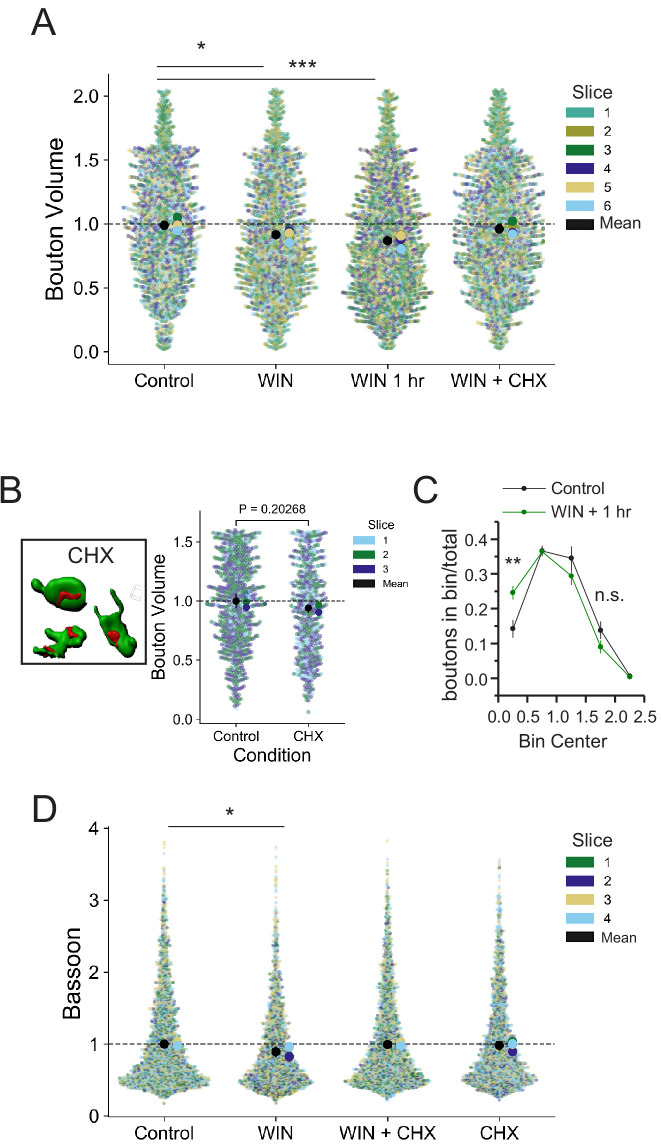
Individual bouton and Bassoon sizes are altered by CB1-iLTD induction in a protein synthesis-dependent manner.(A) Quantification of bouton volume normalized to control by slice. Activation of CB1 receptors with 5 µM WIN for 25 min led to decreased bouton volume that remained 1 hr after WIN treatment and was diminished by treatment with cycloheximide (CHX, 80 µM, applied throughout the experiment). Superplot shows individual bouton volume values color-coded by slice in swarmplot with solid larger dots overlaid representing mean bouton volume per slice. Overall mean of slices is indicated with the black circle, 95% CI is indicated with the vertical black line. Control: 1.0 ± 0.02 vs. WIN: 0.92 ± 0.02 vs. WIN + 1 hr: 0.87 ± 0.02 vs. WIN + CHX: 0.98 ± 0.02 (Mean ± S.E.M.); F[3,20]=8.40, p=0.00082, one-way ANOVA with post-hoc Tukey test for multiple comparisons. WIN vs. Control: CI [−0.15,–0.0015], p=0.044, WIN 1 hr vs. Control: CI [−0.19,–0.048], p=0.00077, WIN + CHX vs. WIN 1 hr: CI[0.02,0.16], p=0.0095. n = slices (three images/slice, one slice/rat, six rats/condition). 95% Confidence intervals (CI) are given as CI[lower CI, upper CI]. P-values are exact. (B) Left, Representative single CB1 boutons with Bassoon reconstructed in 3D. Right, Quantification of bouton volume normalized to control. CHX had no significant effect on basal CB1 bouton volume. Control 1.0 ± 0.03 v. CHX: 0.94 ± 0.02, Two sample t-test, p=0.20267. n = number of slices (three images/slice, one slices/rat, three rats/condition). Superplot shows individual bouton volume values color-coded by slice in swarmplot with solid larger dots overlaid representing mean bouton volume per slice. Overall mean of slices is indicated with the black circle, 95% CI is indicated with the vertical black line. Control: 1.0 ± 0.06 v. WIN: 1.07 ± 0.09 (Mean ± S.E.M.); Two sample t-test, p=0.49581, n = number of slices (five slices, five rats per condition). (C) CB1 activation shifts distribution to smaller sizes. Plot shows boutons in each bin divided by total boutons measured in a slice. Bin [0–0.5]: Control: 0.143 ± 0.025 vs. WIN + 1 hr: 0.246 ± 0.02, Two-sample t-test, p=0.009. Bin [1.5–2.0]: Control: 0.138 ± 0.025 vs. WIN + 1 hr: 0.09 ± 0.019, Two-sample t-test, p=0.16, n.s. = non significant, n = 6 slices, six animals per group. (D) Quantification of Bassoon after 25 min WIN treatment revealed a reduction in active zone volume as measured using Bassoon immunolabeling that was impaired by treatment with cycloheximide (CHX, 80 µM, applied throughout the experiment). Superplot shows individual Bassoon volume values color-coded by slice in swarmplot with solid larger dots overlaid representing mean volume per slice. Overall mean of slices is indicated with the black circle, 95% CI is indicated with the vertical black line. Control: 1.0 ± 0.01 vs. WIN: 0.89 ± 0.04 vs. CHX + WIN: 1.0 ± 0.01 vs. CHX: 0.98 ± 0.03 (Mean ± S.E.M.); F[3,12]=4.11, p=0.032, one-way ANOVA with post-hoc Tukey test for multiple comparisons. WIN vs. Control: CI[−0.22,–0.004], p=0.042. n = number of slices (three images/slice, one slice/rat, four rats/condition). 95% Confidence intervals (CI) are given as CI[lower CI, upper CI]. p-Values are exact.